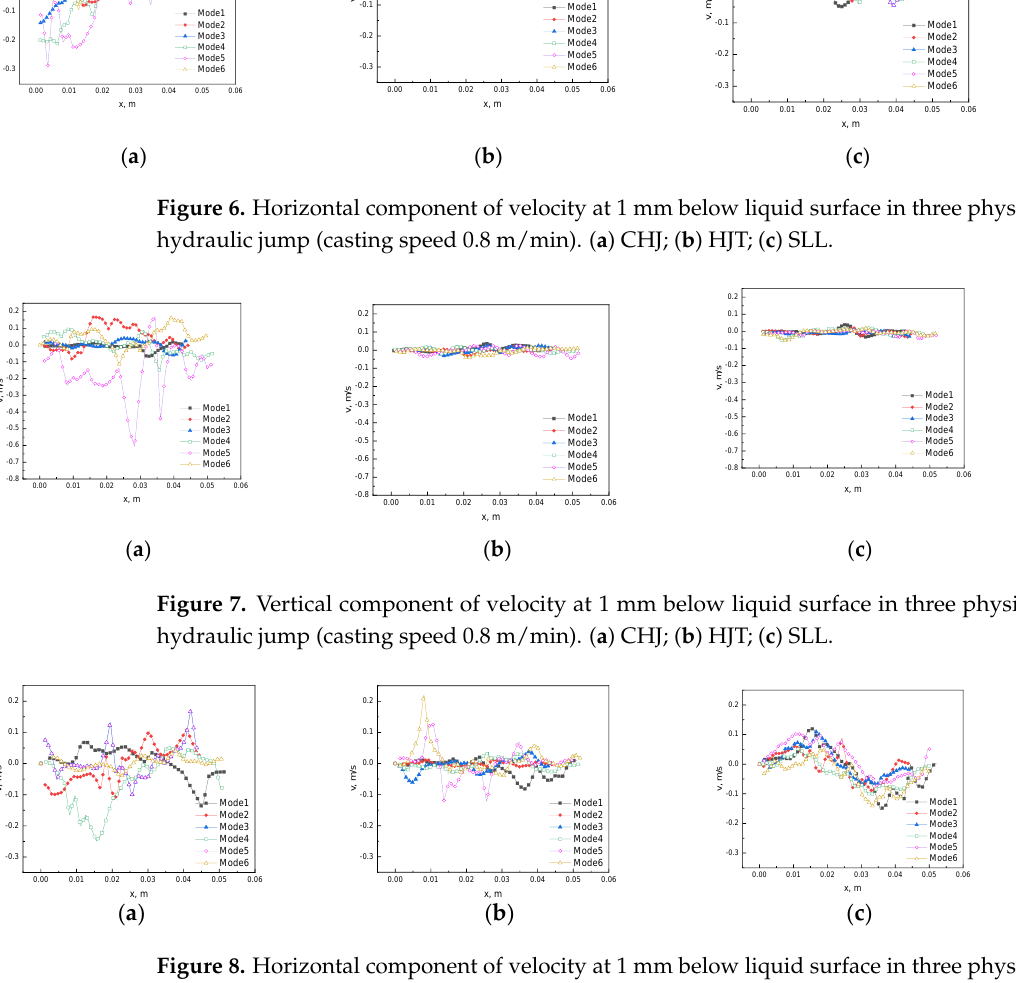
( c ) Figure 9. Vertical component of velocity at 1 mm below liquid surface in three physical forms of hydraulic jump (casting speed 2.4 m/min). ( a ) CHJ; ( b ) HJT; ( c ) SLL. In CHJ, with solidification, the horizontal component of velocity on the left side is negative, the horizontal component of velocity on the right side is positive, and the verti- cal component of velocity is mostly negative, which obviously forms the flow rushing to both sides of the wall and sputtering upward, combined with Figures 2 – 5 (the velocity is also obtained by software PIVlab processing the information of the photos) ; without solidification, most modes have already begun to form backflow to the cen- ter of the mold. This is because solidification increases the resistance to flow and slows the progress of the hydraulic jump. After CHJ, the velocity decays rapidly. In order to better illustrate the effect of the solid – liquid interface morphology on the hydraulic jump behavior (including height and duration), the results of the control exper- iments without solidification are given in Figures 10 – 12. The liquid-level height of different modes at two different casting speeds with or without solidification in three hydraulic jump forms is shown in Figure 10. It can be seen that the average liquid-level height in SLL increases with the increase in the casting speed in general, and the liquid-level height in HJT has little relationship with the mode and solidification. ( a )